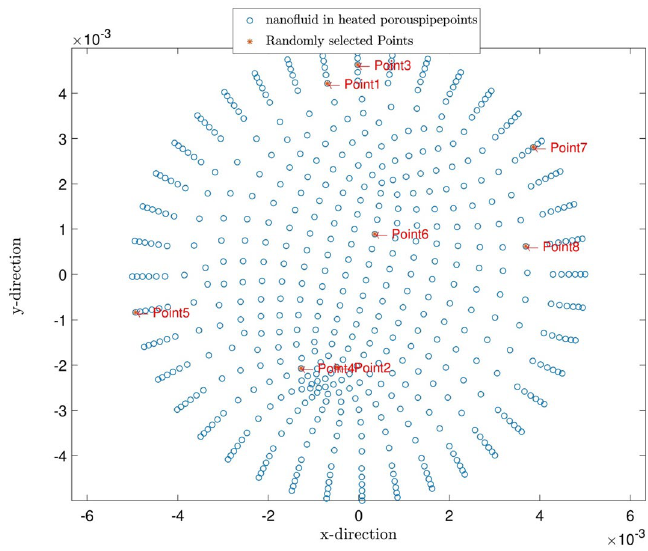
Figure 8. Random points for pattern recognition of pressure in different nanoparticle fractions.